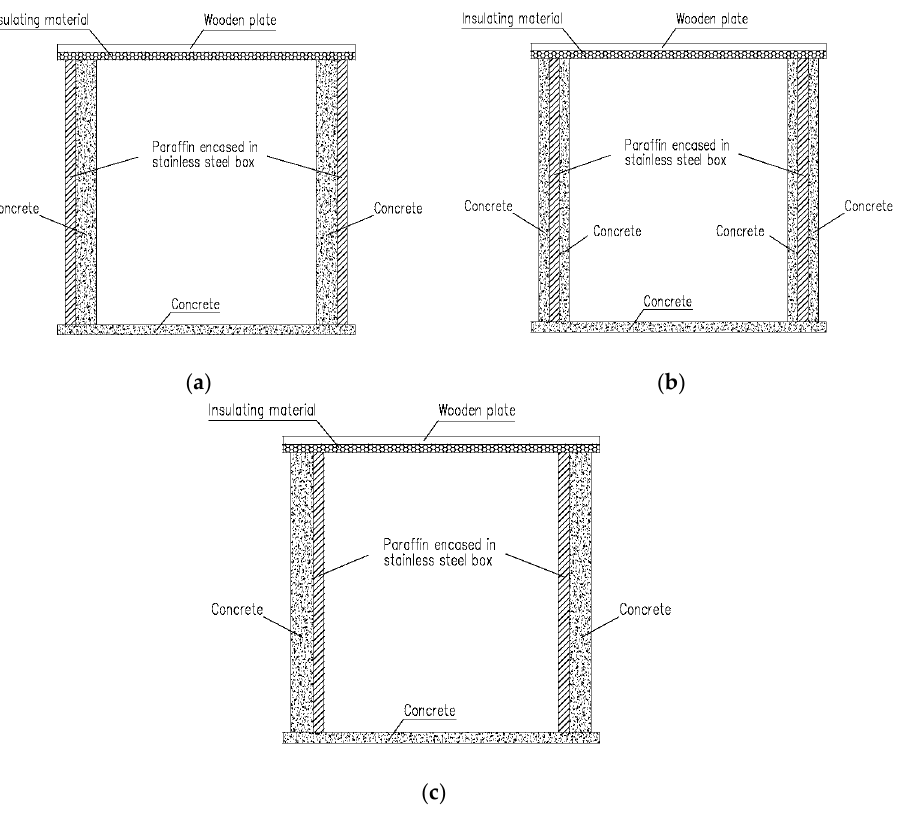
Figure 2. Room model ( a ) Externally bond with concrete wall (Type I); ( b ) Laminated within concrete wall (Type II) and ( c ) Internally bonded with concrete wall (Type III).